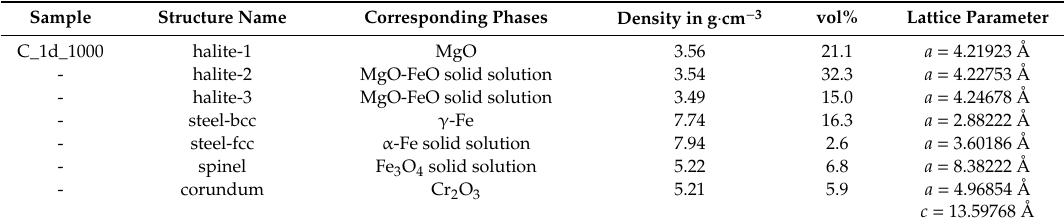
Figure 15. XRD pattern of the C_1000 crucible surface at the contact interface with aluminum alloy (detected phases designated based on their crystal structure). Phases detected at the surface of the C_1000 sample (designated based on their crystal